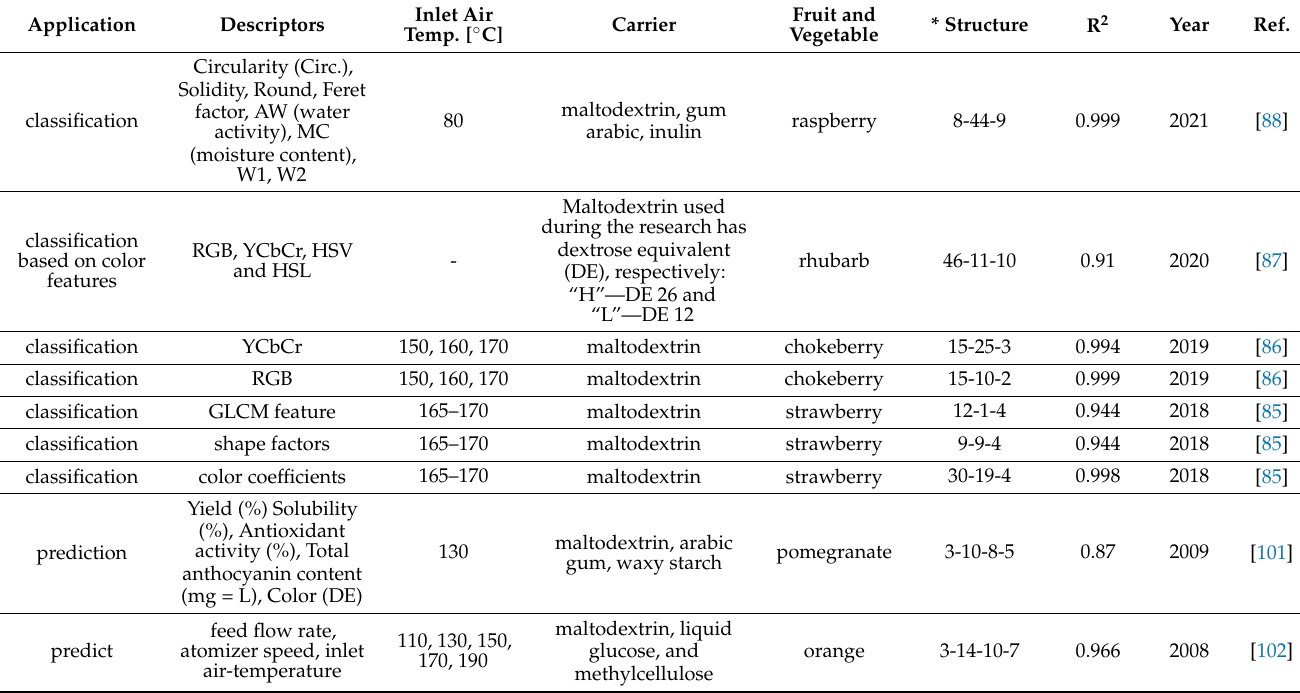
Table 2. Applications of multi-layer perceptron by using spray-drying from 2007 to